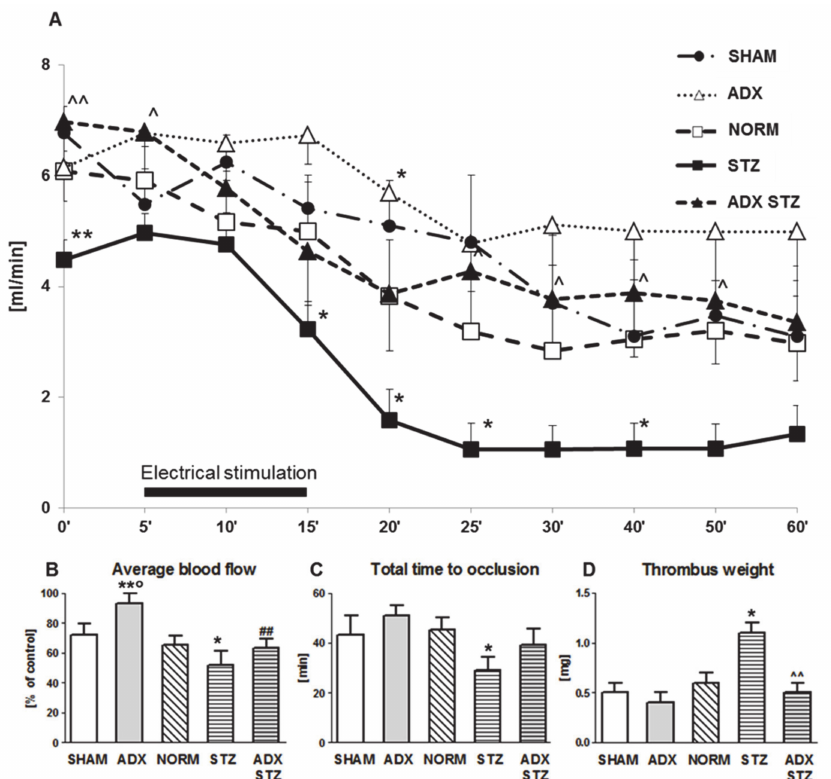
Figure 1. Time-course of mean blood flow and thrombus formation in a rat common carotid artery. ( A ) The mean carotid blood flow during the entire experiment; ( B ) average blood flow; ( C ) total time to occlusion; ( D ) thrombus weight; SHAM—sham-operated rats, ADX—adrenalectomized rats, NORM—normoglycemic, control rats, STZ—streptozotocin-induced diabetic rats, ADX STZ— adrenalectomized streptozotocin-induced diabetic rats. Data are presented as mean ± SEM; * p < 0.05, ** p < 0.01 vs. NORM; ◦ p < 0.05 vs. SHAM; ˆ p < 0.05, ˆˆ p < 0.01 vs. STZ; ## p < 0.01 vs. ADX; n =